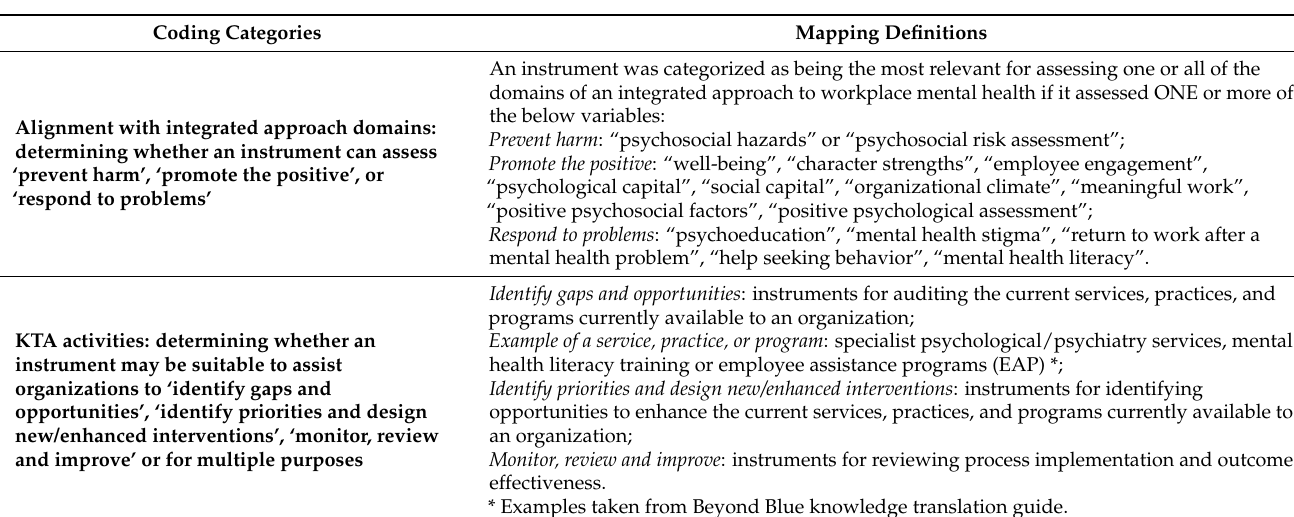
Table 2. Definitions used for mapping instruments to the integrated approach domains and knowl- edge to action (KTA)